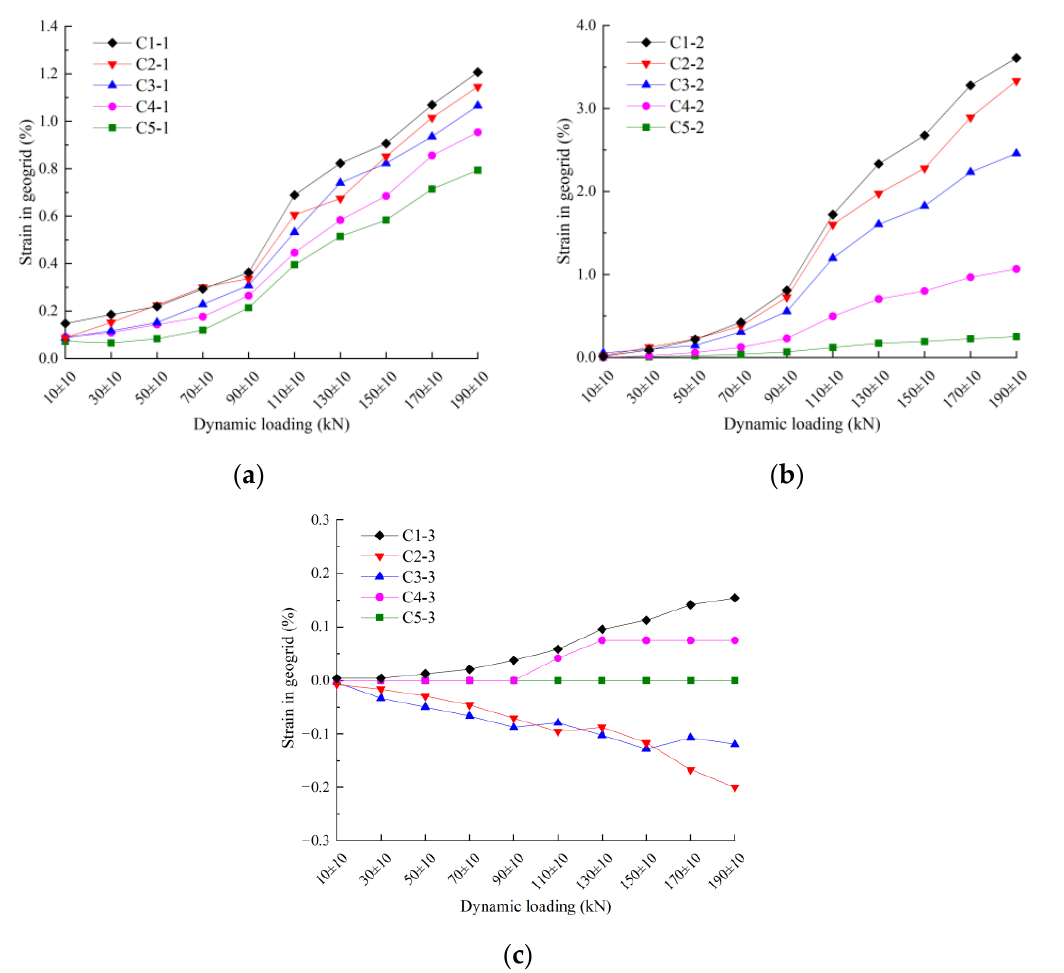
Figure 9. Geogrid strain (equal amplitude loading). ( a ) Connection position to the facing panels. ( b ) Below the loading plate. ( c ) Anchorage position.